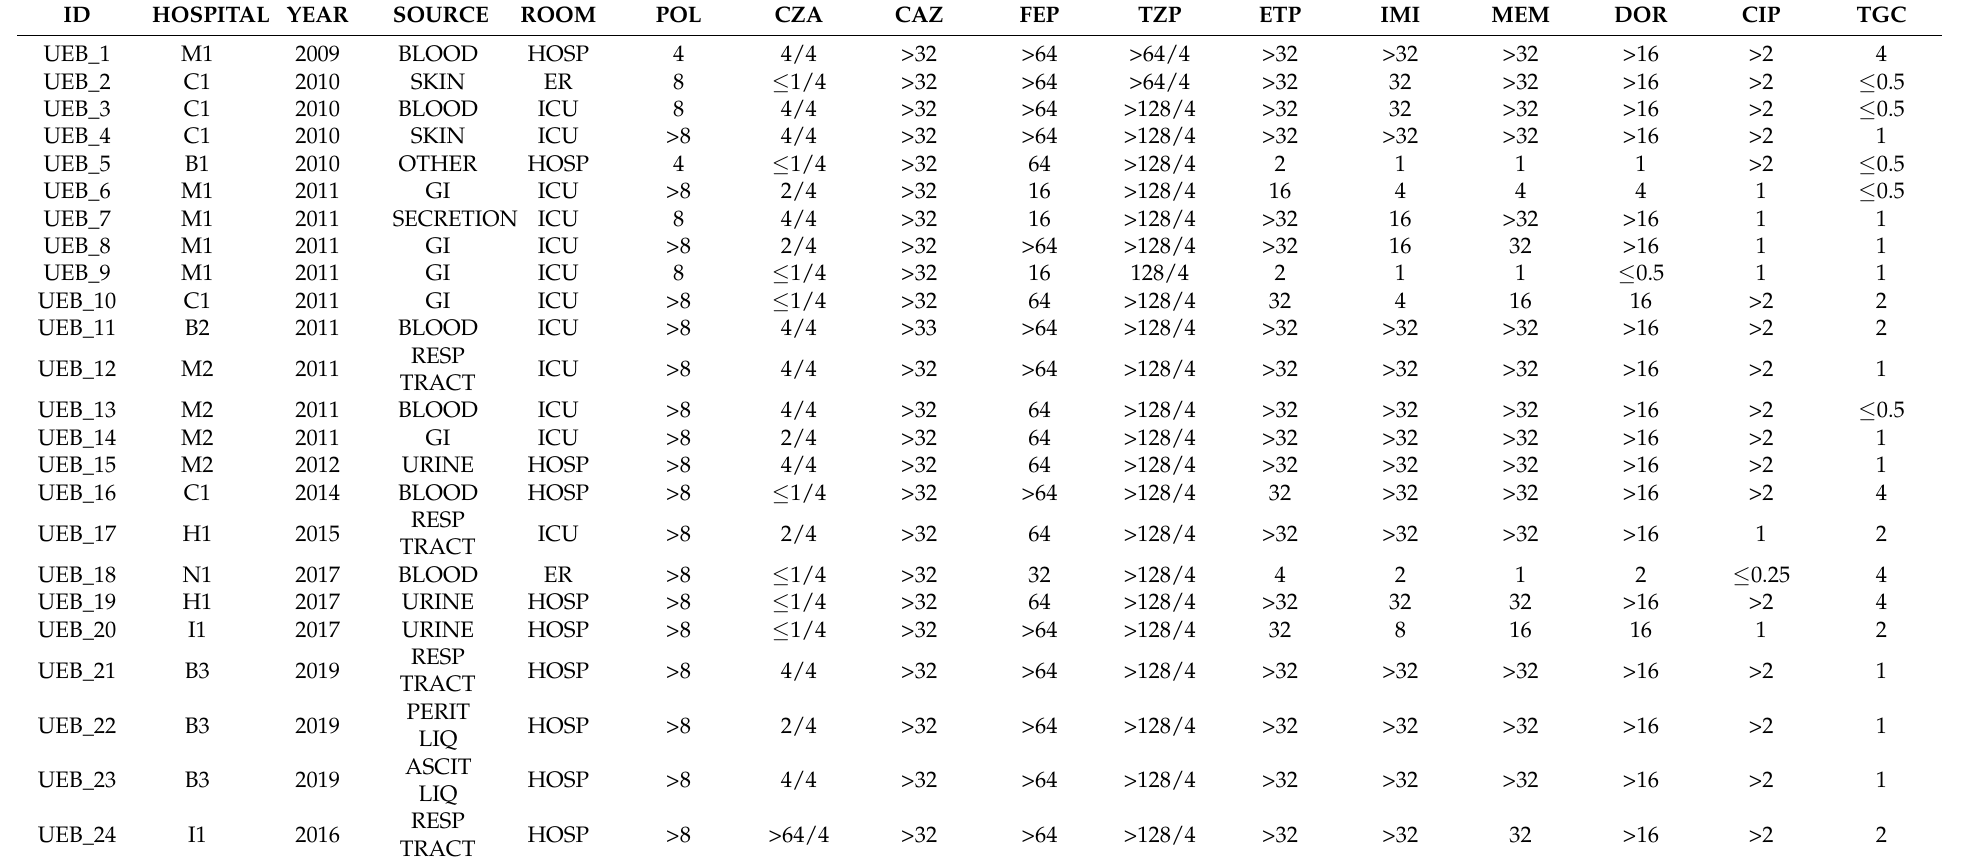
Table 1. Characteristics and minimum inhibitory concentrations of polymyxin-resistant K. pneumoniae